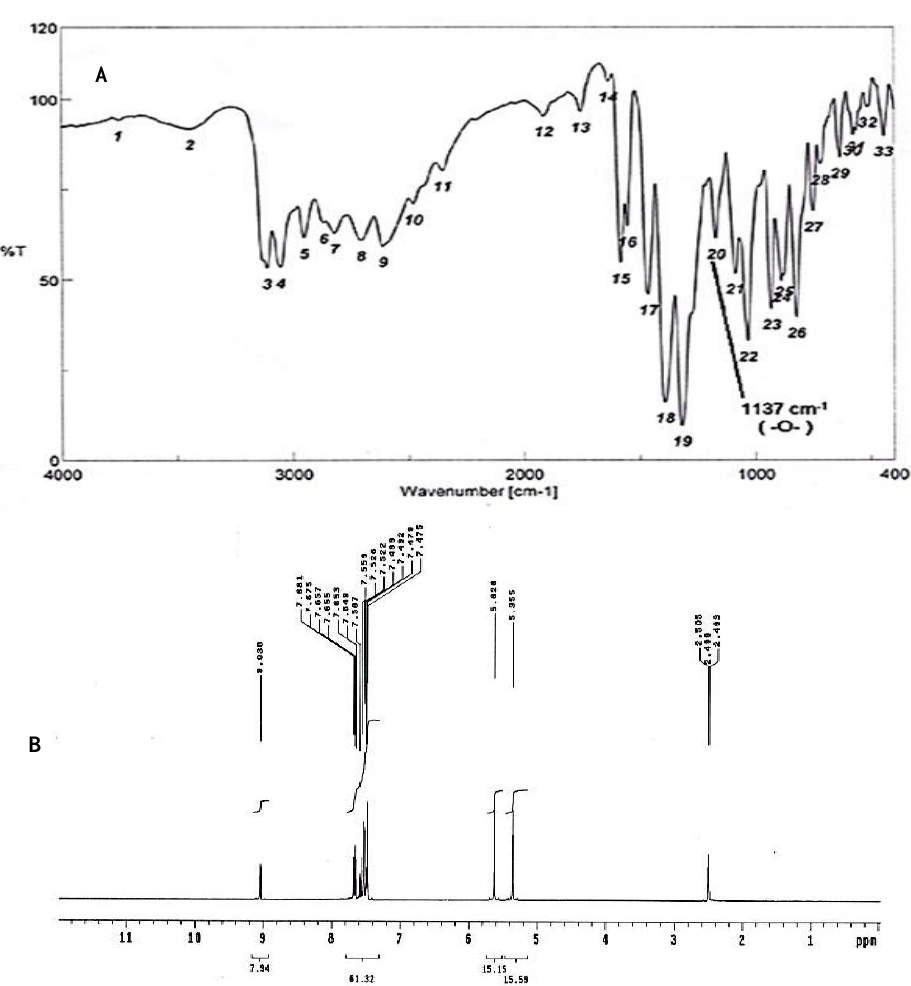
Figure 4. Elucidation of the structure of the antifungal substance(s). ( A ): Infrared (IR) spectrum of the antifungal compound produced by S.atrovirensKM192347. ( B ): 1 H NMR spectrum of the antifungal compound produced by S. atrovirens KM192347 (DMSO-N 6 ).